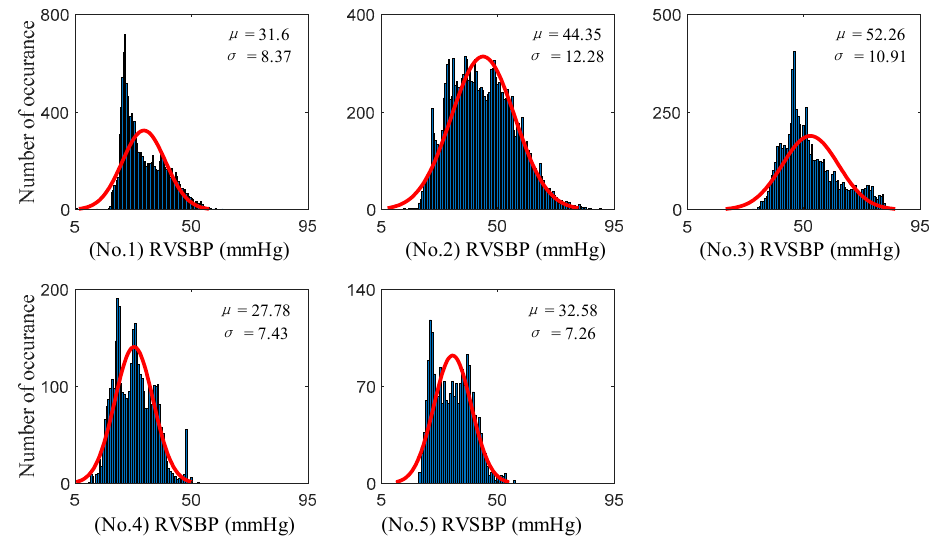
Figure 10. Histogram of RVSBP distribution. Table 3. Summary of regression coefficients.